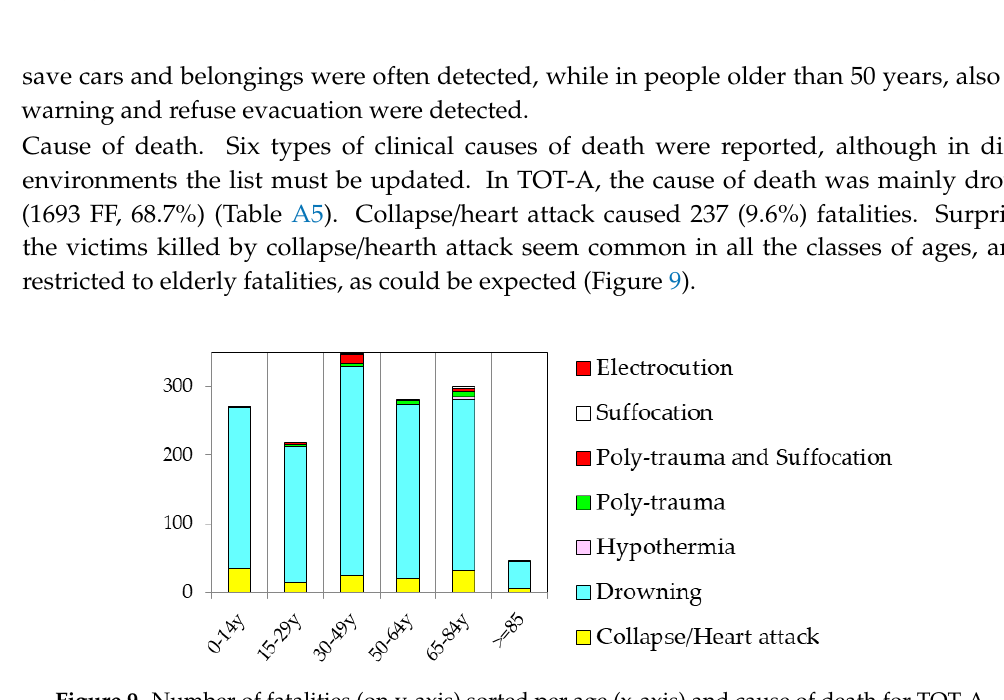
Figure 9. Number of fatalities (on y-axis) sorted per age (x-axis) and cause of death for TOT-A.